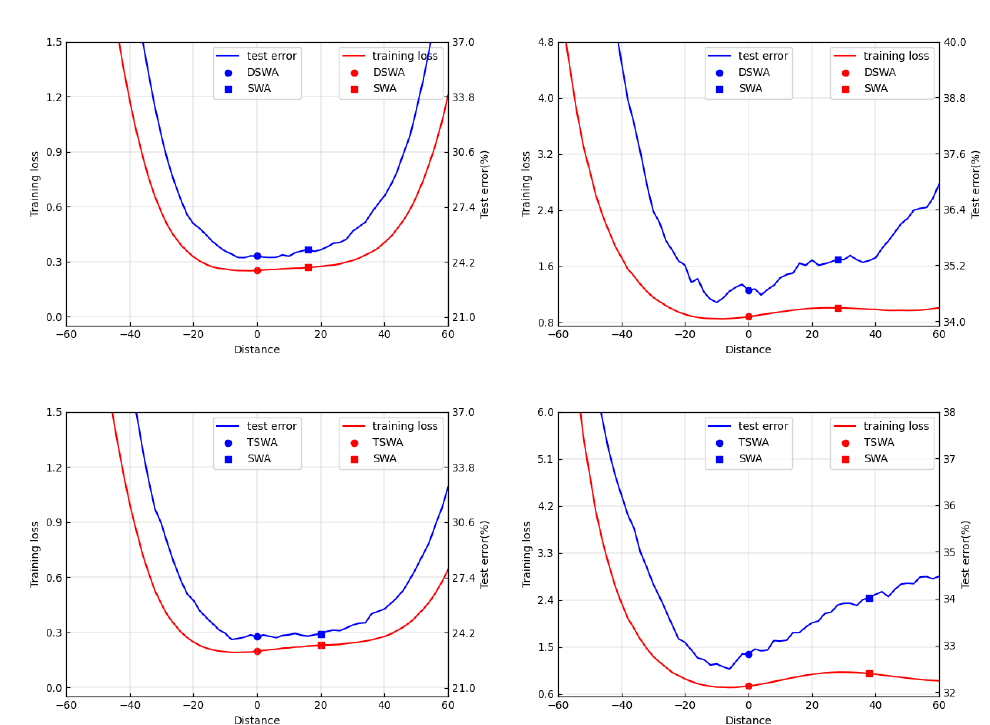
Figure 5. Cross-entropy training loss and testing error as a function of a point on the line connecting the SWA and DSWA (or TSWA) solutions on CIFAR-100. DSWA and TSWA were initialized by a non-converged preceding SGD procedure. Left: PreResNet-164. Right: VGG16.